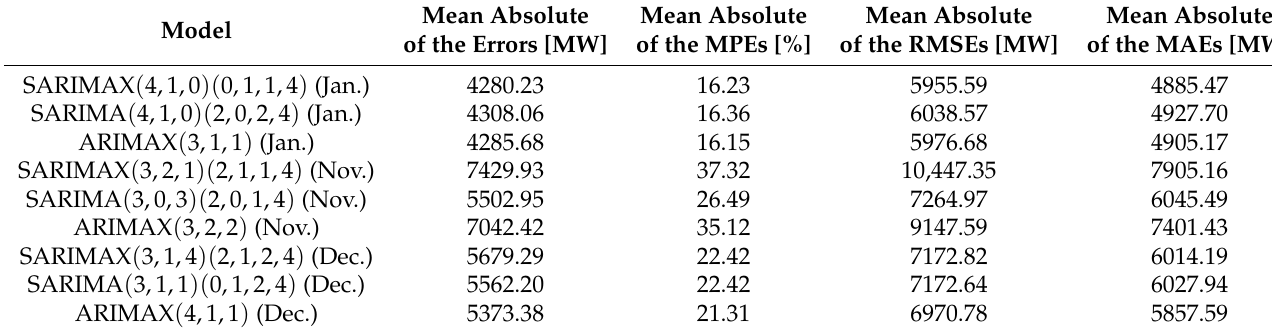
Table 10. Evaluation of the best model candidates for forecasting the power generation of renewable energy sources. Mean Absolute Mean Absolute Mean Absolute Mean Absolute Model of the Errors [MW] of the MPEs [%] of the RMSEs [MW] of the MAEs [MW] SARIMAX ( 4, 1, 0 )( 0, 1, 1, 4 ) (Jan.) 4280.23 16.23 5955.59